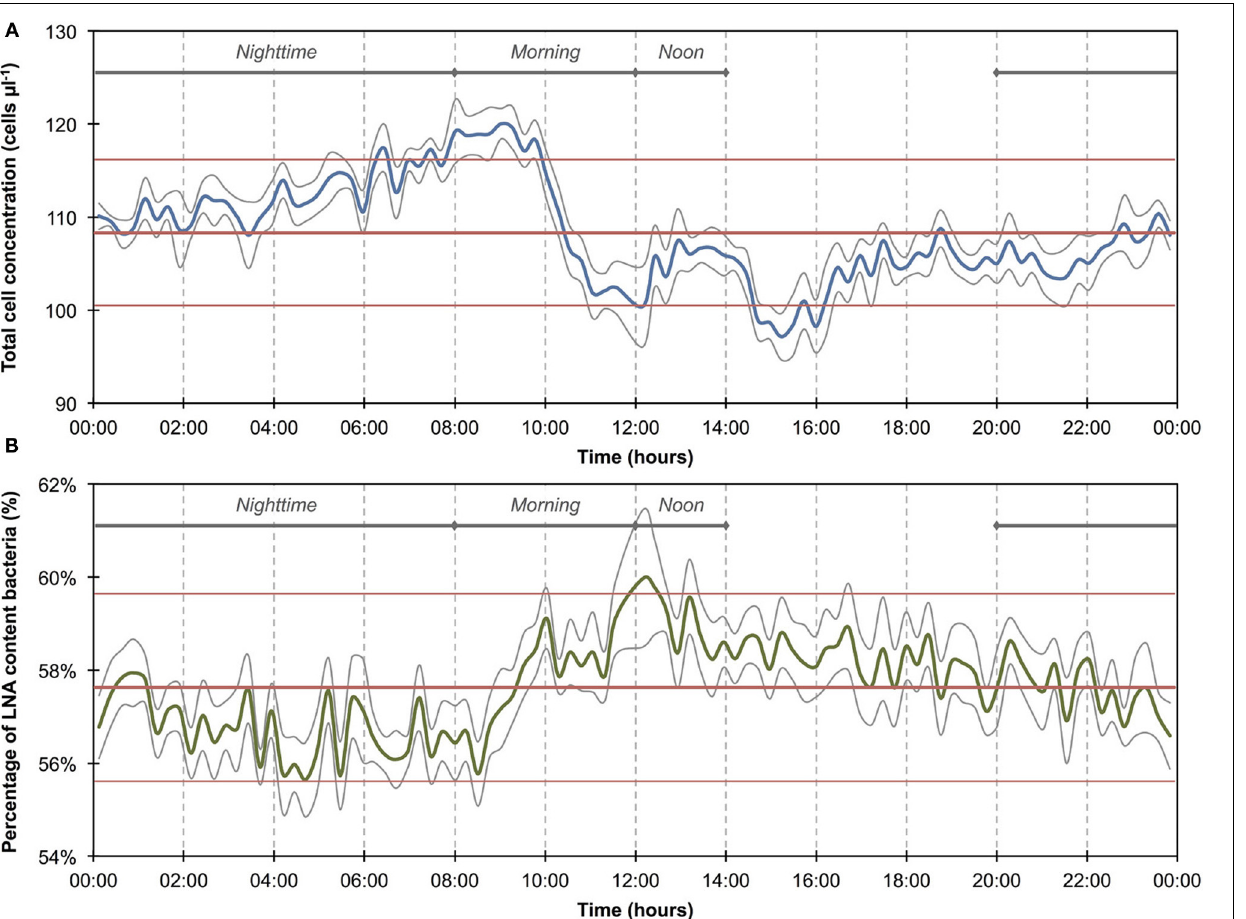
FIGURE 2 | Baseline data of the daily microbiological fluctuations in continuously flowing municipal tap water for total cell concentrations (A) and percentage LNA content bacteria (B). The data set ( n = 674) comprises only weekday data, excluding weekends and the apparent event ( Figure 1 ). Blue and green lines are 15-min